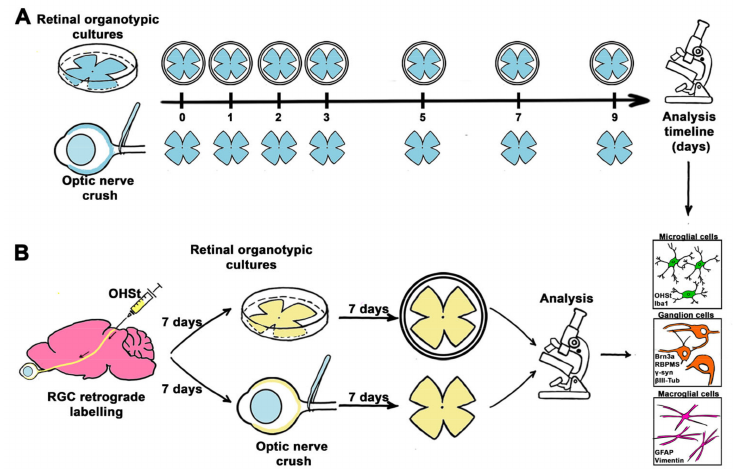
Figure 1. Experimental design. ( A ) Comparative study of RGCs and glial cells between ROCs and ONC. ( B ) Assessment of phagocytic microglial cells after ONC and in